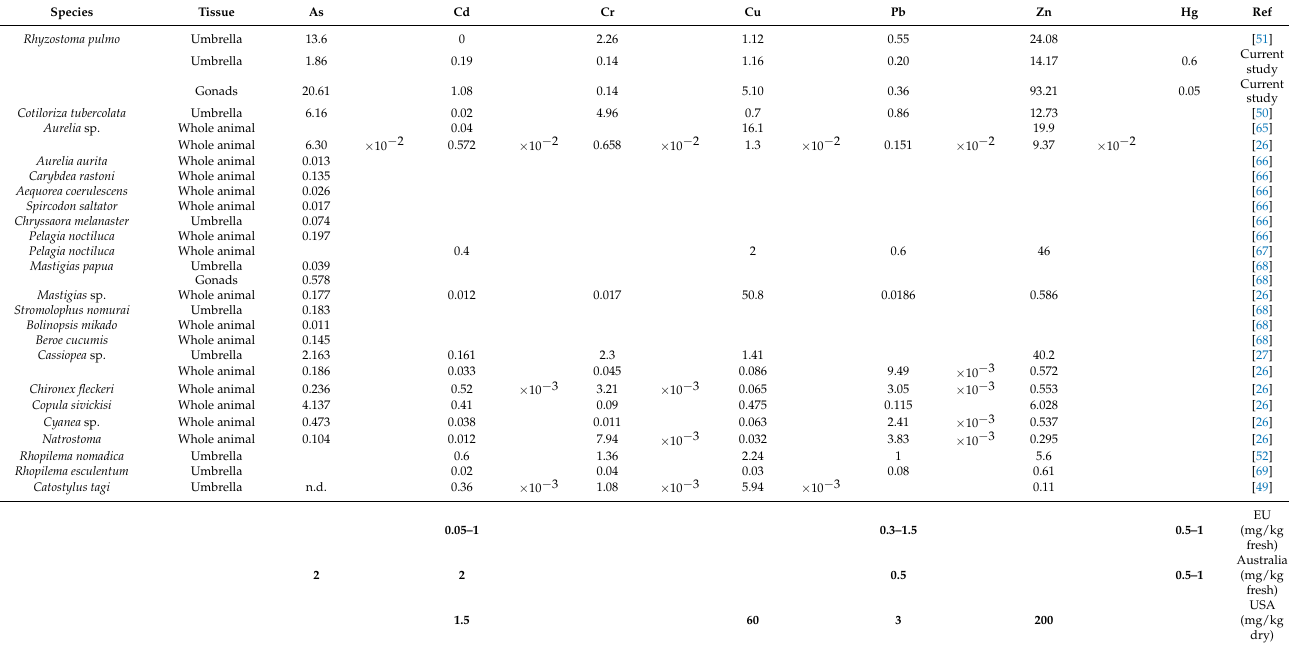
Table 6. Mean content of heavy metals and metalloids in jellyfish (mg/kg dry weight, ppm) reported in other studies. Bottom of the table, bold: maximum allowed metal content in marine food according to USA # (dry weight, ppm), EU* (wet weight, ppm), and Australia** (wet weight, ppm) legislations. # CFR: Code of Federal Regulations Title 21 Food and Drugs, https://www.ecfr. gov/cgi-bin/text-idx?SID=d00d5bf8686e0d306a7e63512c39baf6&mc=true&tpl=/ecfrbrowse/Title21/21tab_02.tpl (accessed on